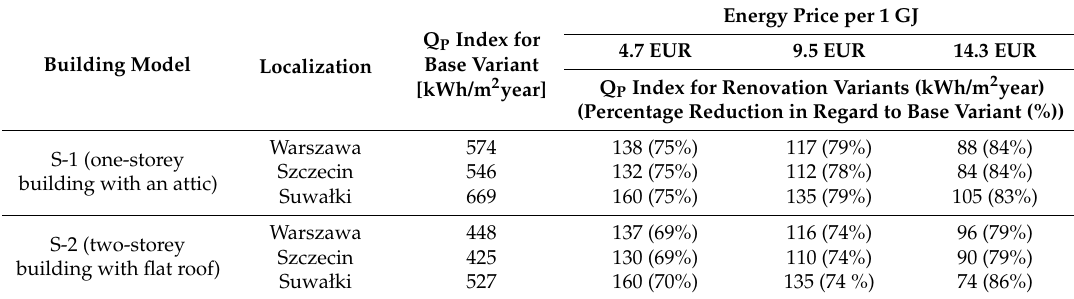
Figure 4. Primary non-renewable energy demand for different building models, renovation variants, and locations. Table 19. Change of the primary, non-renewable energy index after renovation to the cost-optimum variant.